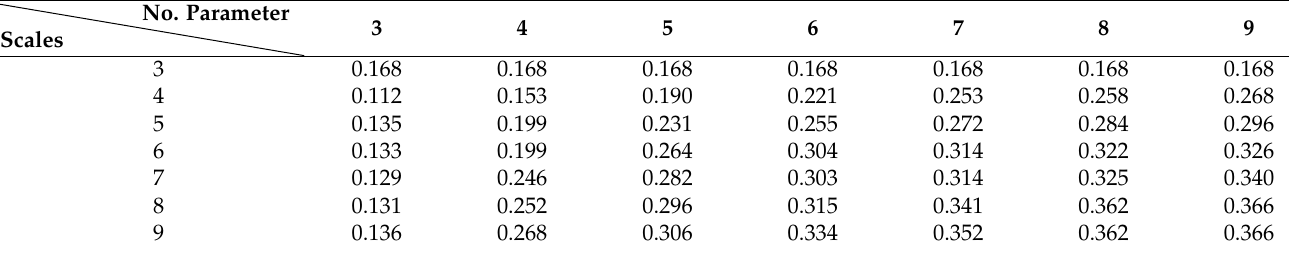
Table 9. The threshold of C.R. in BWM.